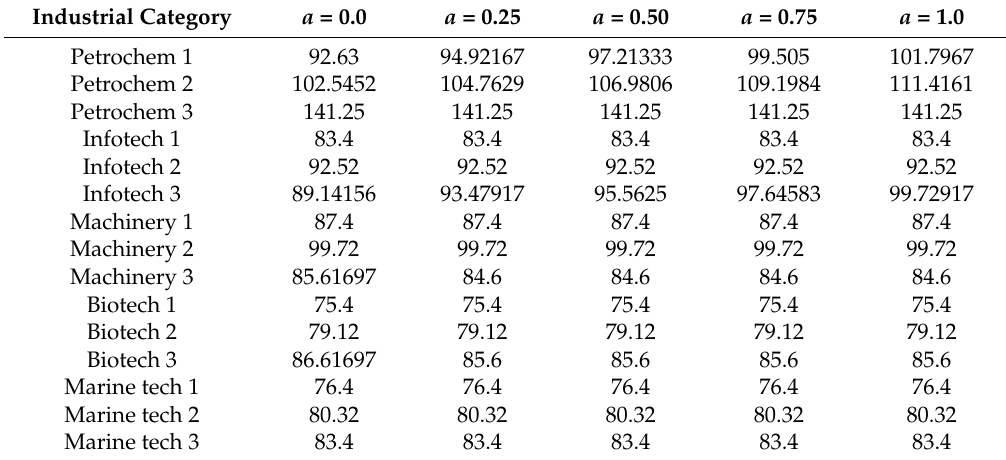
Table 7. Recycled water usage for industrial users under acceptance degrees (10 6 m 3